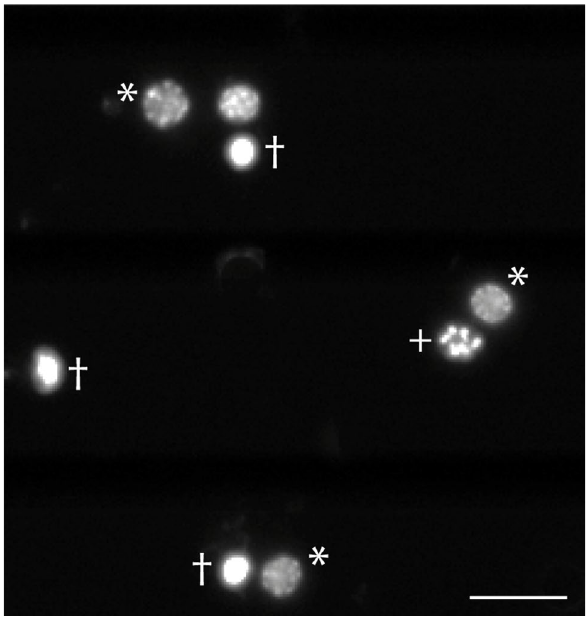
Figure 4. DAPI stained T. castaneum primary neurons. Cell survival was analysed by automatic counting nuclei of intact (*), dying (+) and dead (†) neurons. Scale bar 10